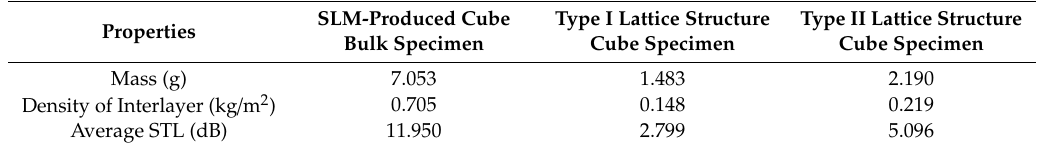
Table 3. Average STL (sound transmission loss) values of the three di ff erent structural cube